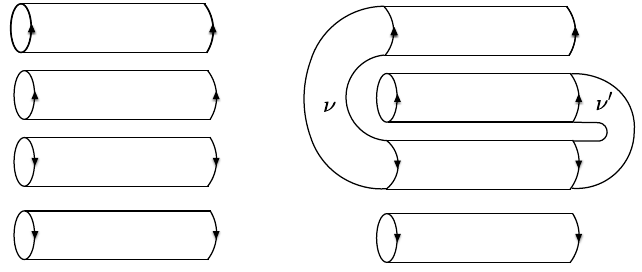
(cid:21)A (cid:10) . On the left,we have a 2 N C 2 A 0 h (cid:10) j e (cid:0) j i !